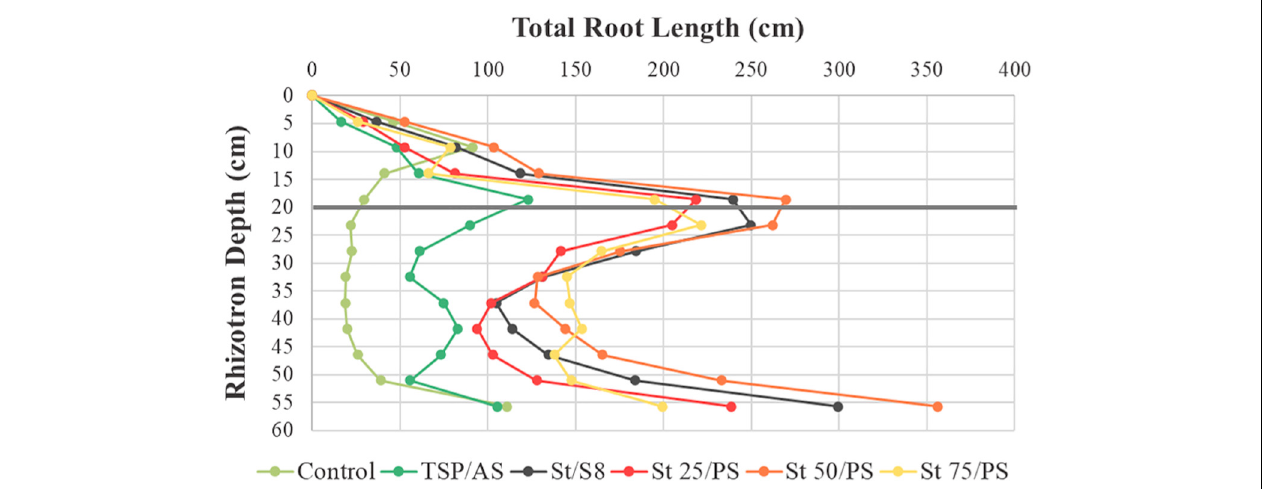
FIGURE 5 | Effect of treatments on visible total root length. Trends of root length density over the rhizotron depth are shown at harvest time point (40 days after sowing). The applied fertilizer layer is at a depth of 20 cm from top (marked with the gray line). Dots represent mean